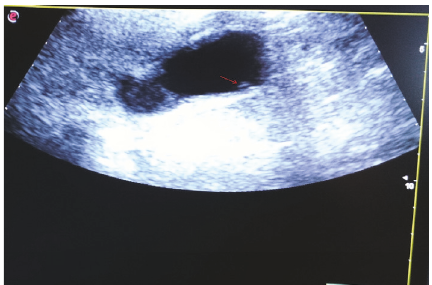
Figure 1: The Ascaris lumbricoides appearing as an echogenic, tubular-shaped, and coiled structure, with anechoic central line (arrow), located in the gallbladder.